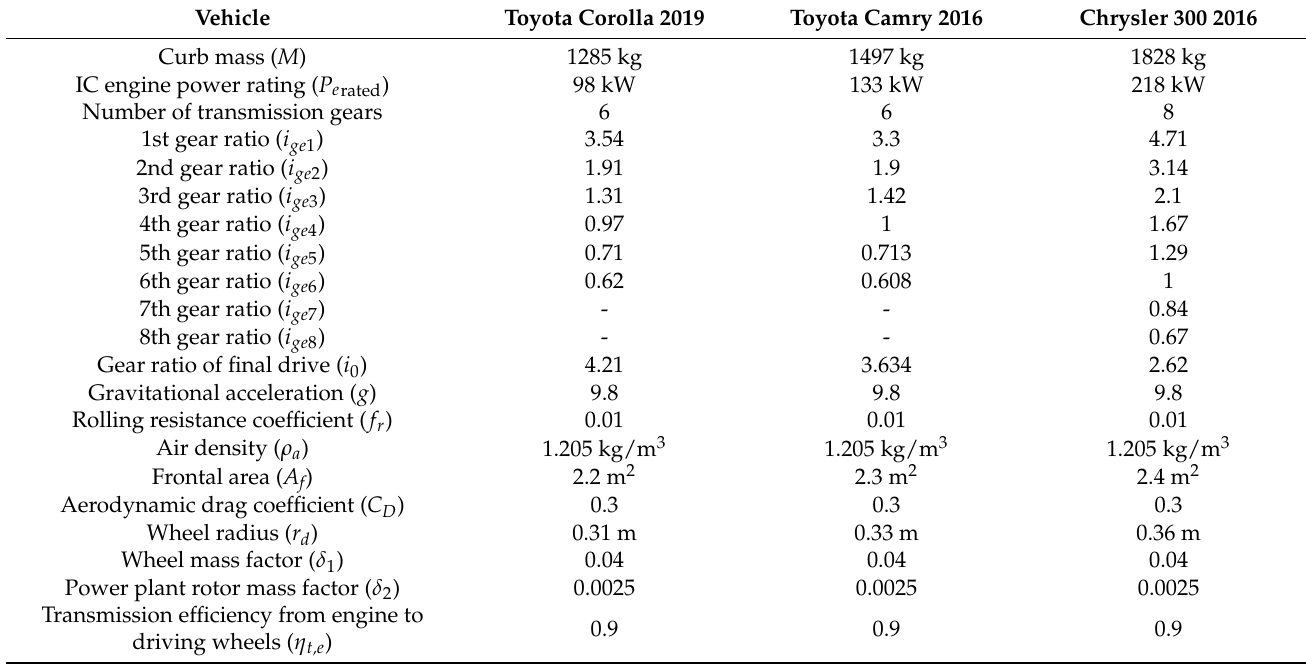
Table 1. Vehicle parameters of 3 typical IC engine vehicles [1,2,12–14].